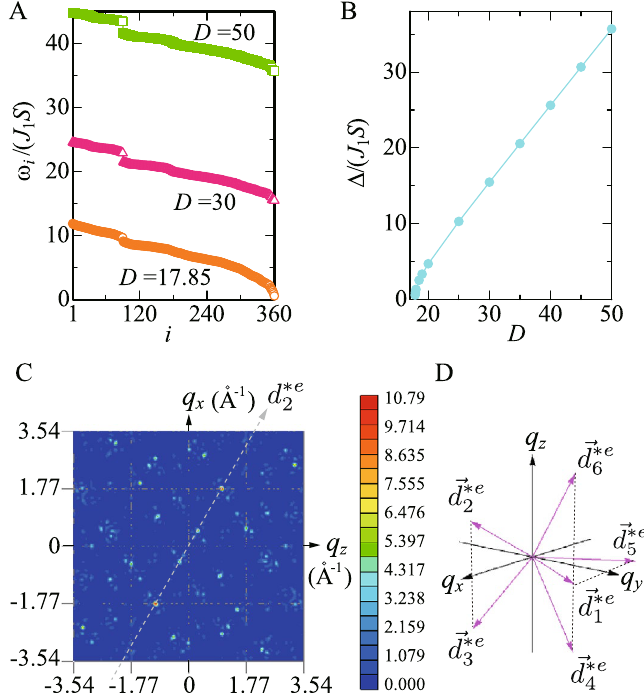
1.0 and J 2 2.3 with various D . ( B ) CEF excitation gap vs D . ( C ) Top view of = = 0 . The gray dashed line in ( C ) denotes the pseudo 5-fold axis d ∗ e 2 defined in ( D ). = e i ( i = 1, . . . , 6 ) as the physical (external)